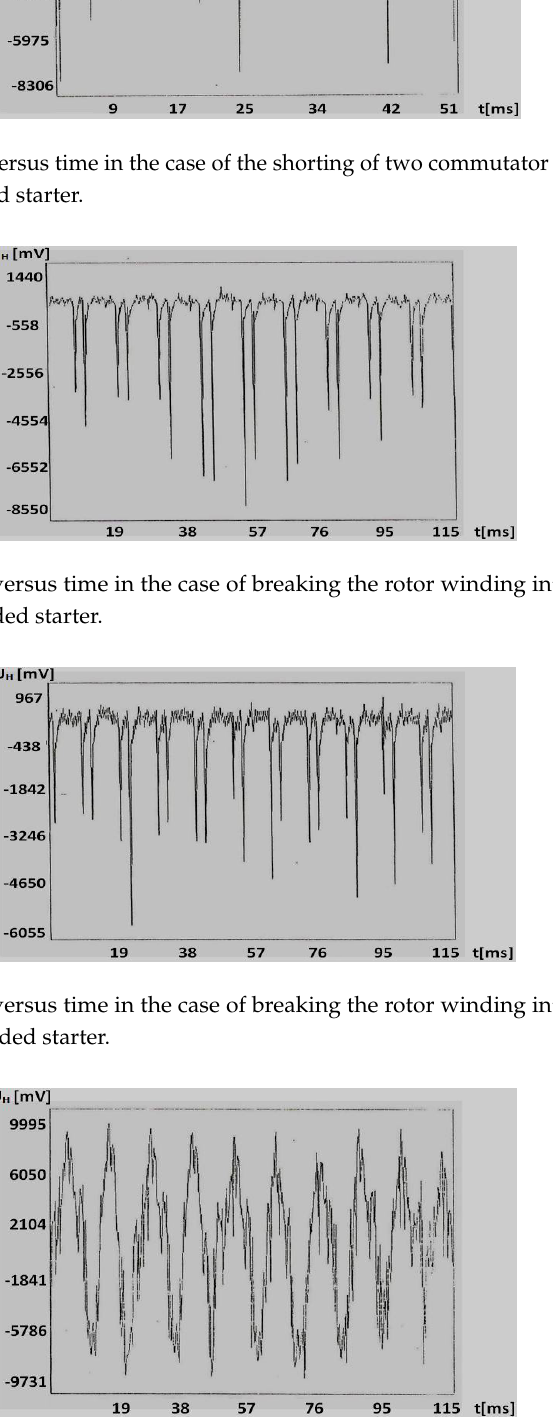
Figure 17. Hall voltage versus time in the case of brush wear, Hall sensors fixed on the rotor, unloaded starter.